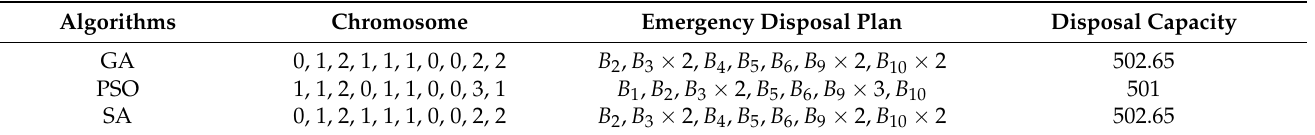
Table 5. Detailed results of different algorithms.